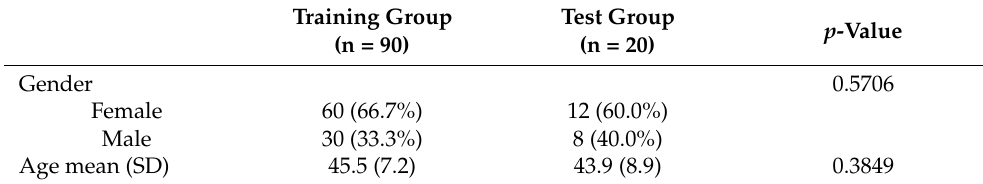
Table 4. Demographic factors for the training and the test groups.